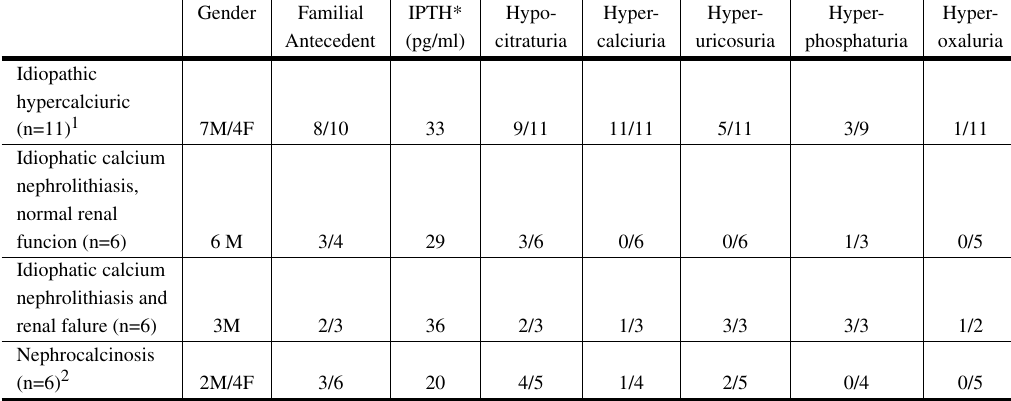
Casuistic, ethiologic diagnoses and urinary metabolic abnormalities in selected patients for CLCN5 mutation